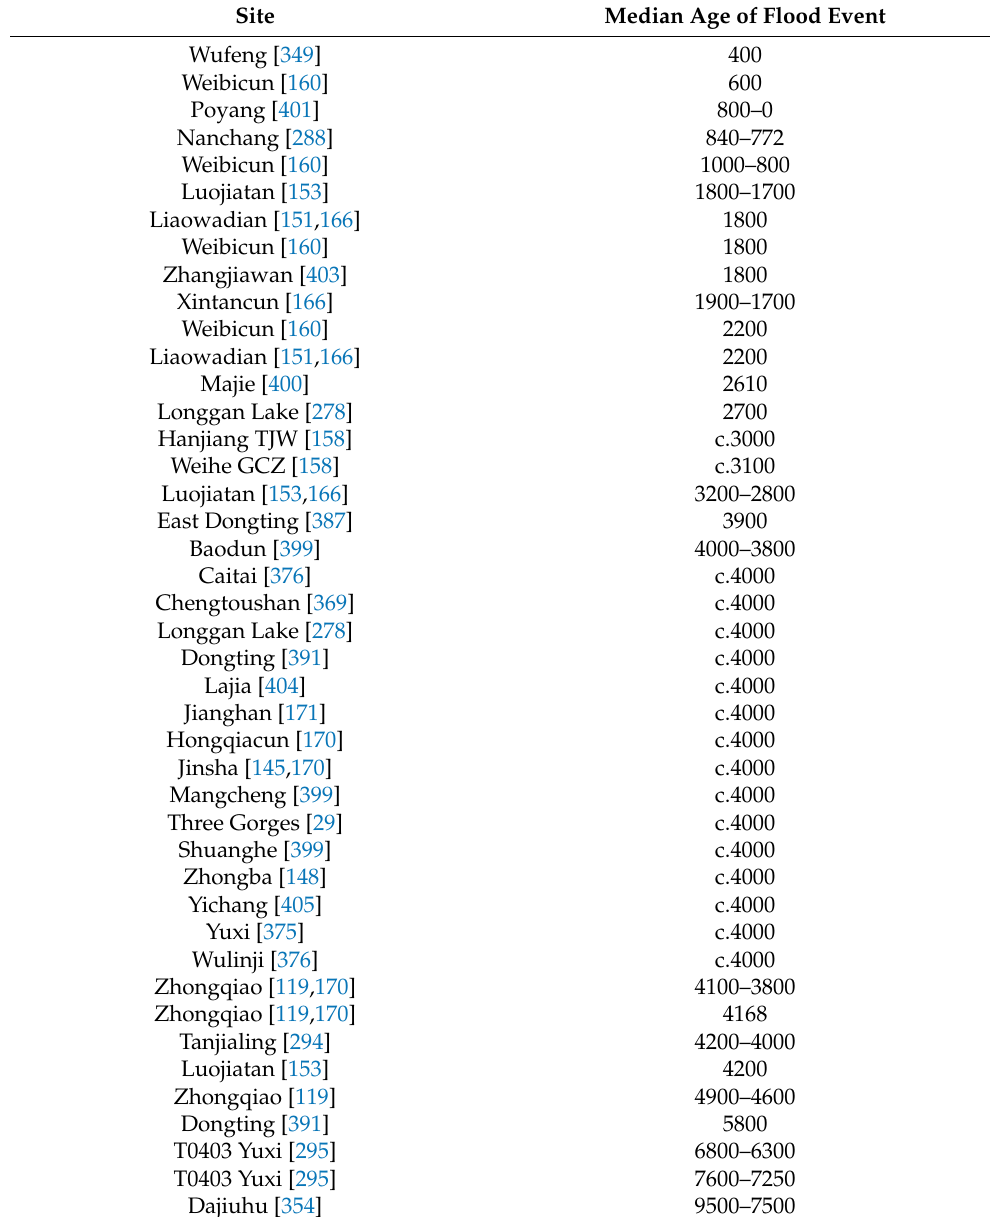
Table 4. Chronology of Holocene fluvial flood events (water level rises) in the upper and mid-Yangtze valley, and in Yangtze tributary headwaters. Dates are in calibrated years BP. Age ranges may include several dates. Some dates are reliable estimates based on other